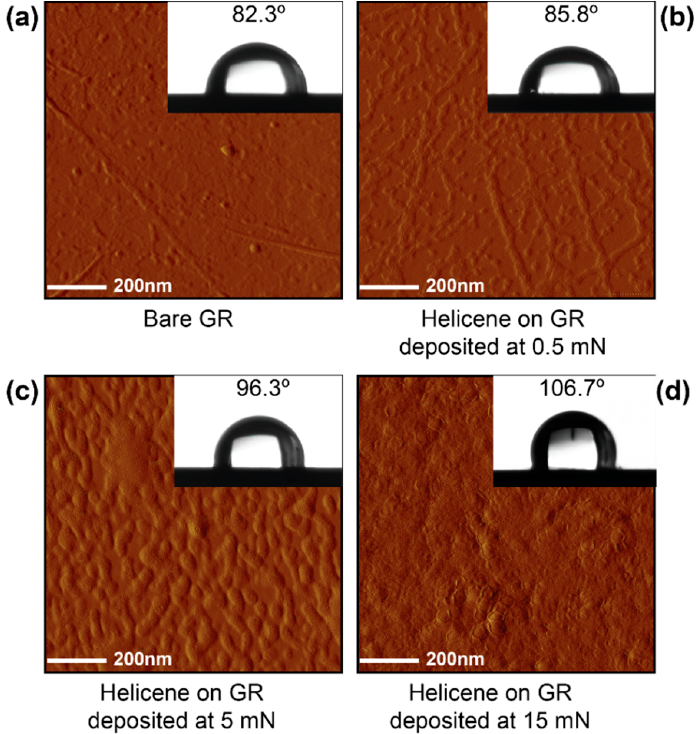
Figure 3. The amplitude error signal and static contact angle of water of/on ( a ) bare GR, ( b ) Gr-H0.5, ( c ) Gr-H5, and ( d ) Gr-H15. All images are 1 µm × 1 µm.